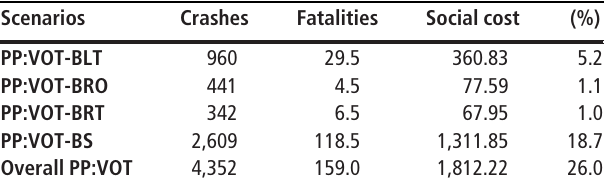
Table II Crashes, fatalities and social cost of PP:VOT